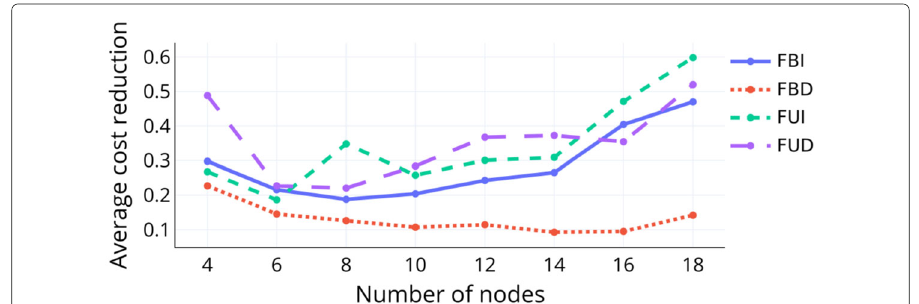
Fig. 7 Average cost reduction compared to the worst relevant tested method, MethodsFBI,FBD,FUI,FUD